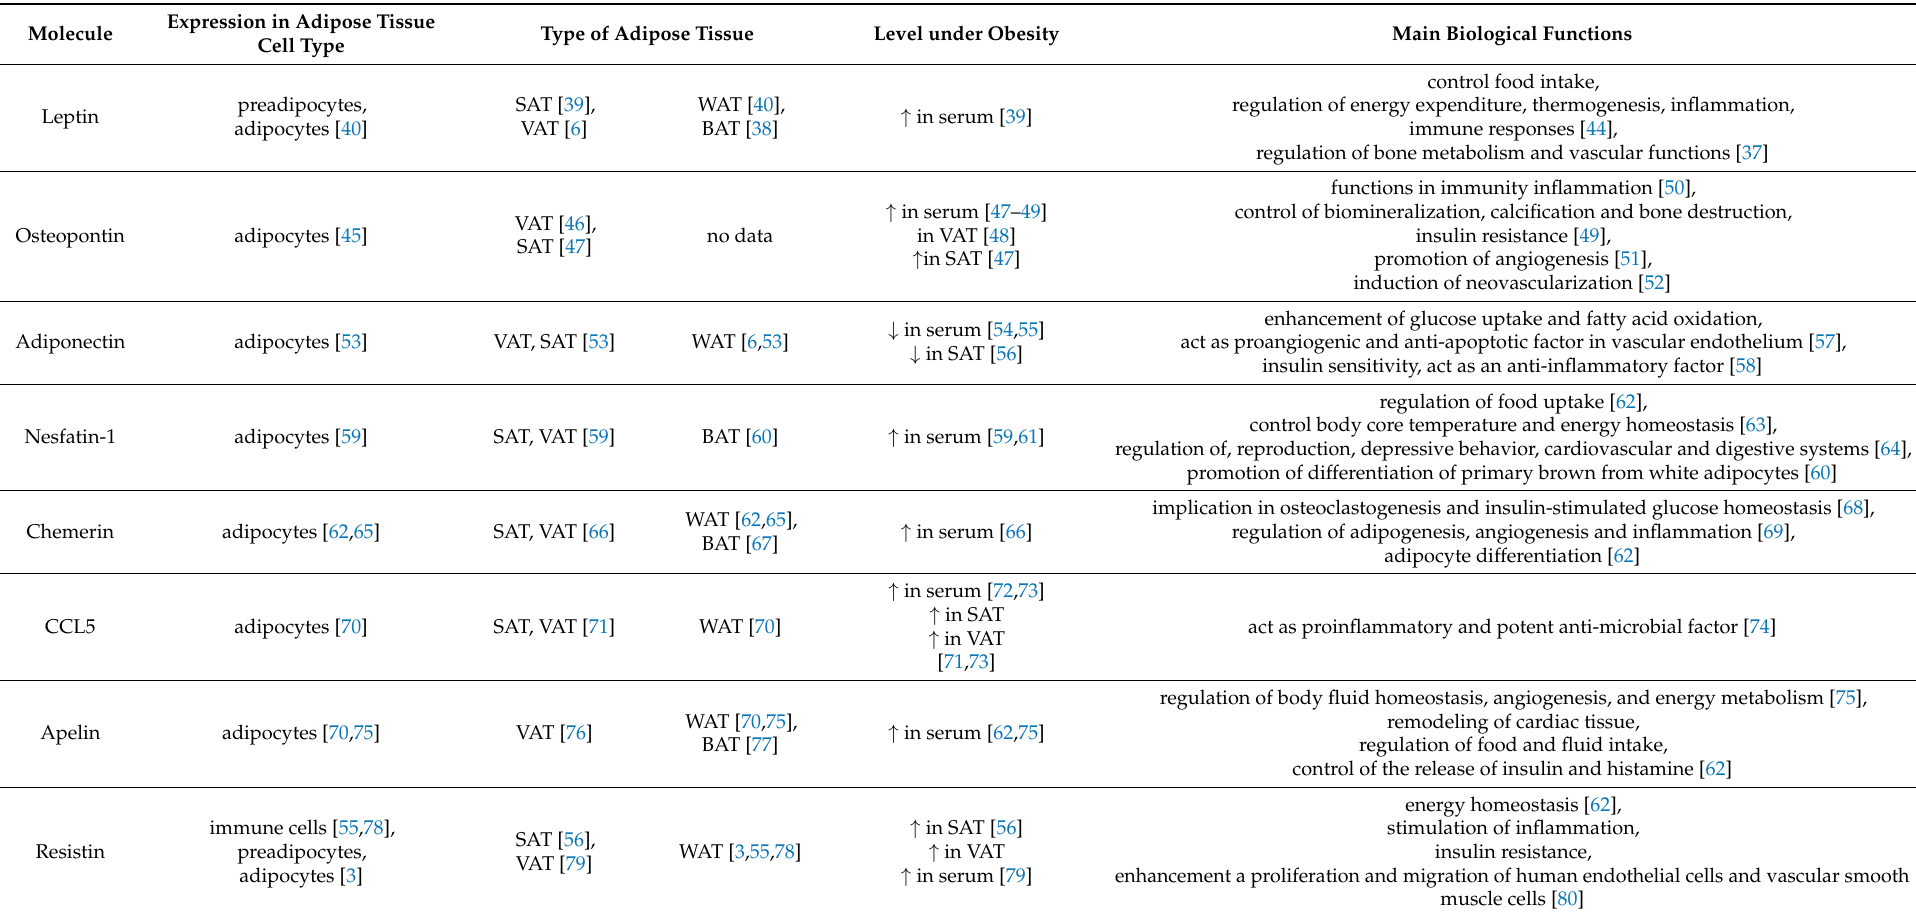
Table 1. Comparison of the influence of factors released by adipose tissue on physiological processes. Abbreviations: AT—adipose tissue, SAT—subcutaneous adipose tissue, VAT—visceral adipose tissue, WAT—white adipose tissue, BAT—brown adipose tissue, ↑ higher level, ↓ lower